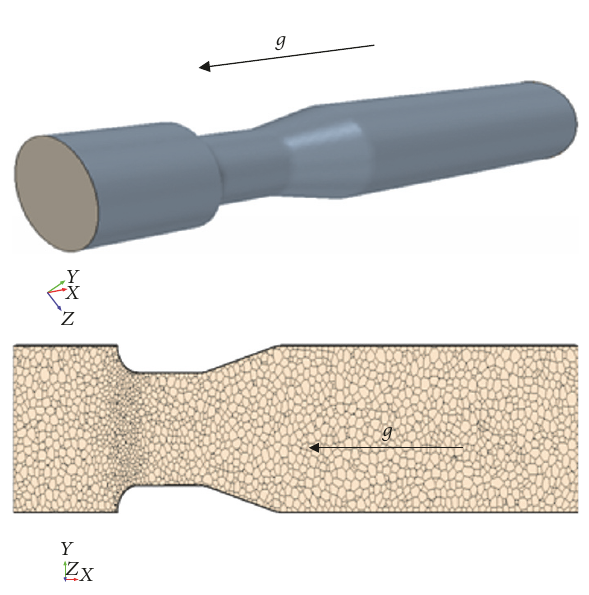
Figure 3: Venturi 3D and 2D